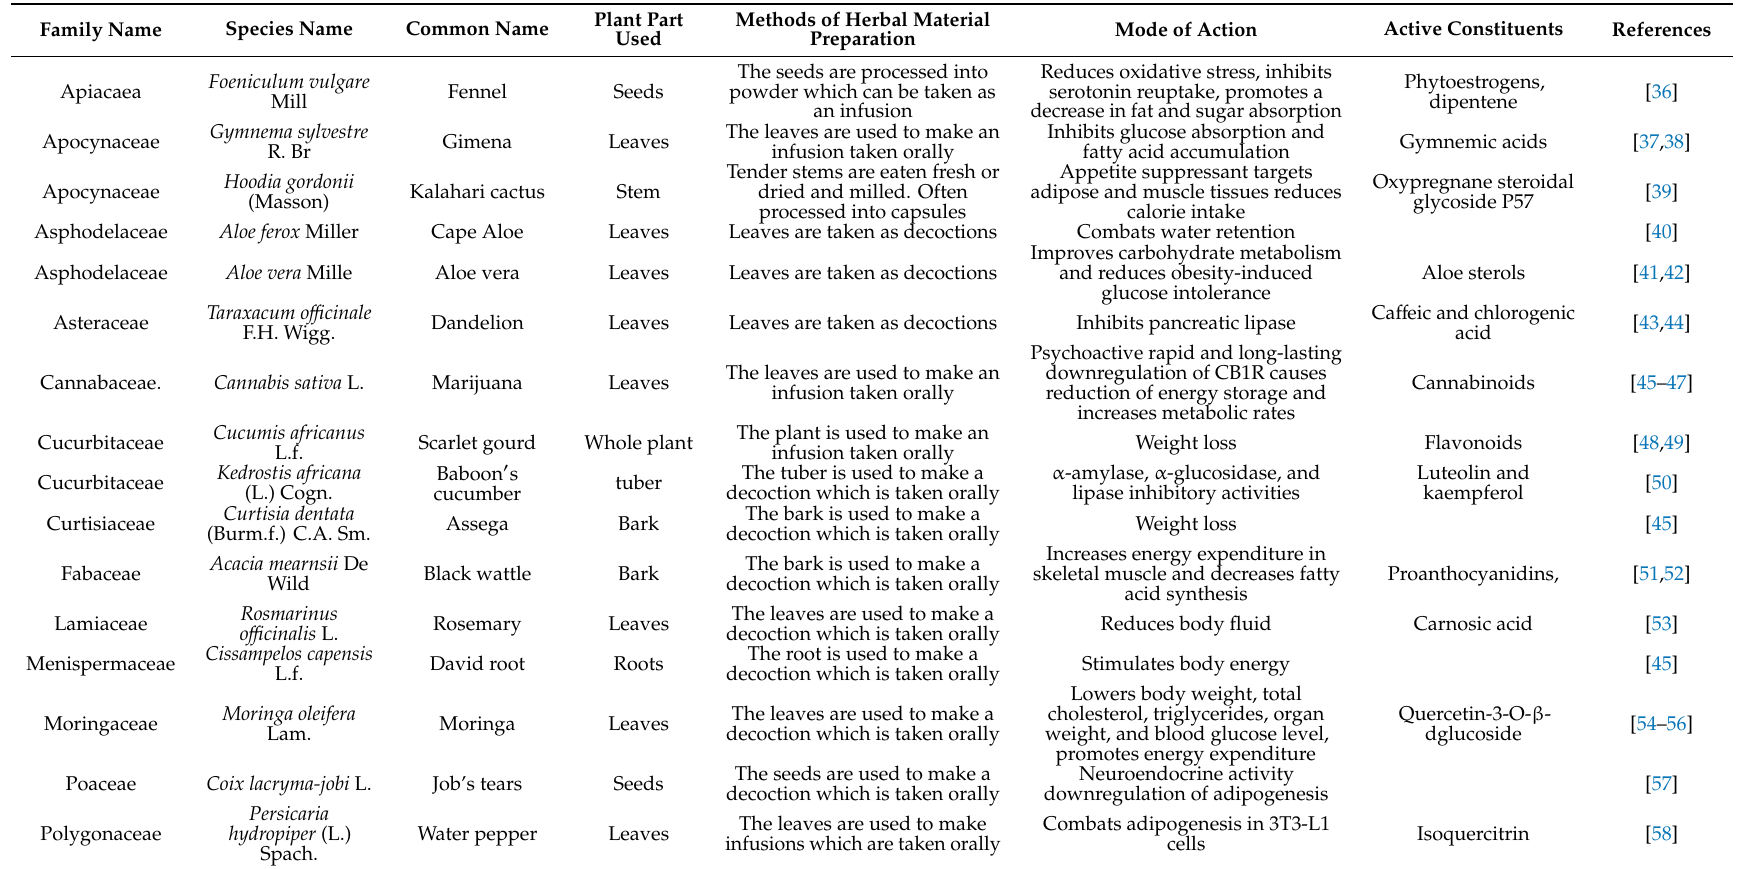
Table 1. Plants in South Africa used for weight